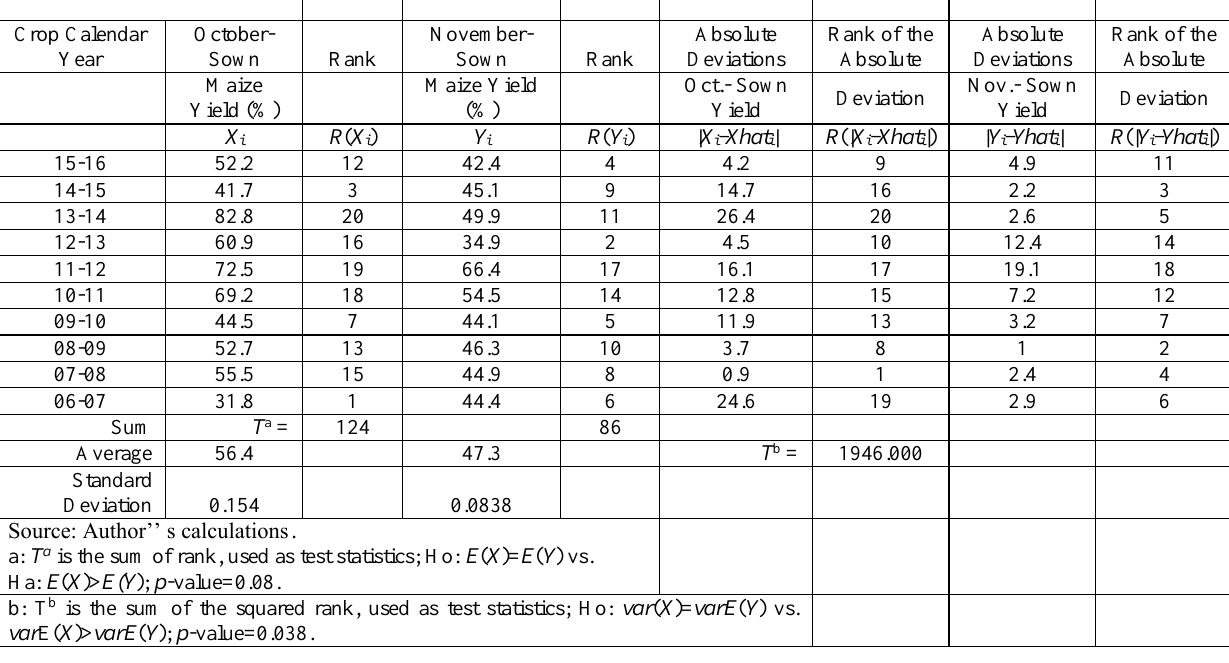
Table 5. Distribution of the Percentage of Rainfall-Based Forecasted Yields over the Potential Yields of Lowland Rice for Two Different Transplantation Time Near Antananarivo (in the Central High-Plains of Madagascar): A Non-Parametric Comparison Crop Calendar Nov. Dec. Absolute Rank of the Absolute Rank of the Rank Rank Year Transplanted Transplanted Deviations Absolute Deviations Absolute Nov. Transplanted Deviation Rice